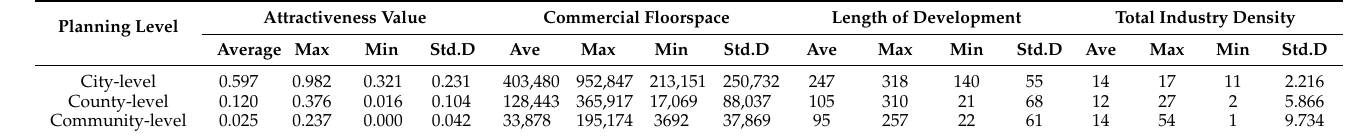
Figure 6. Spatial interaction network among commercial centers and blocks. Table 3. The characteristics of variables among different levels of commercial